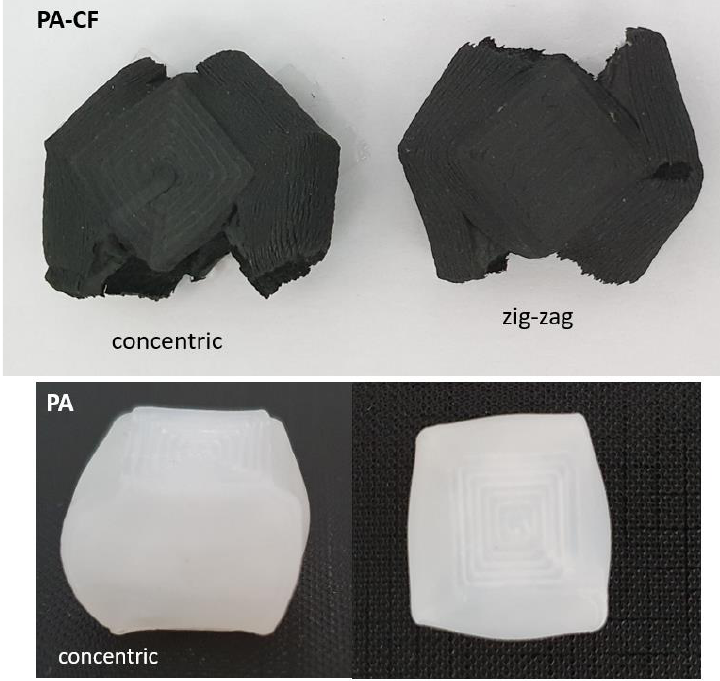
Figure 9. Tested compression samples.